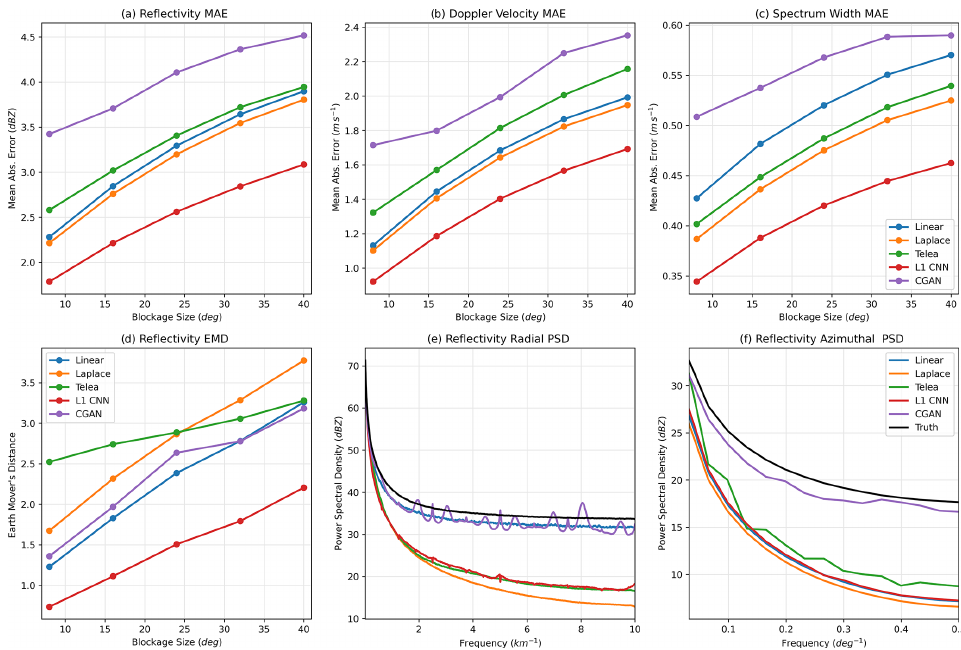
Figure 8. Error metrics computed on the C-SAPR2 beam blockage. Panels (a) – (c) show mean absolute pixel errors. Panel (d) shows the earth mover’s distance. Panels (e) and (f) show power spectral